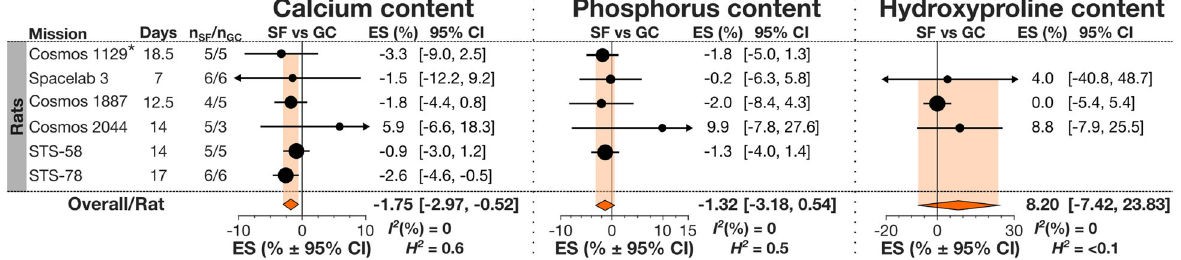
Fig. 6 Space fl ight-induced changes to bone mineral composition in rats. Forest plot of changes in bone calcium ( left ), phosphorus ( middle ), and hydroxyproline ( right ) content of space fl ight animals (SF) compared to ground control (GC). Missions are ordered by mission year (old to recent). Mission name, duration (Days), SF and GC sample sizes (n SF /n GC ) are shown. Circle/line: effect size (%) and 95% CI, the size of the circle is proportional to the mission ’ s weight. Orange diamonds : overall effect size and 95% CI for rats. *indicates missions where there was no GC, and SF was compared to